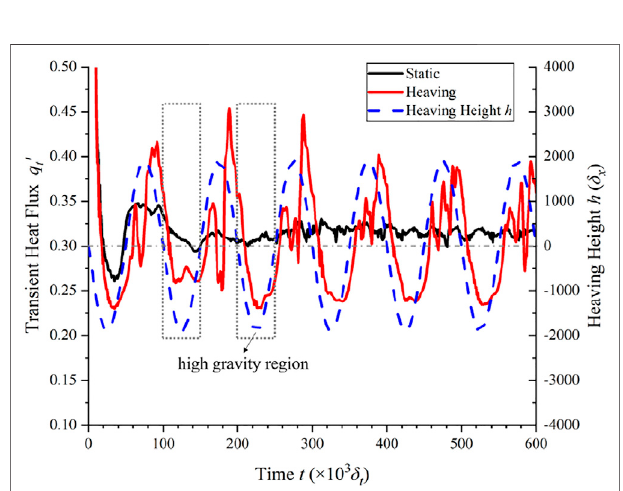
FIGURE 10 | Transient heat fl ux at the nucleate boiling regime with Ja (cid:1) 0.143.